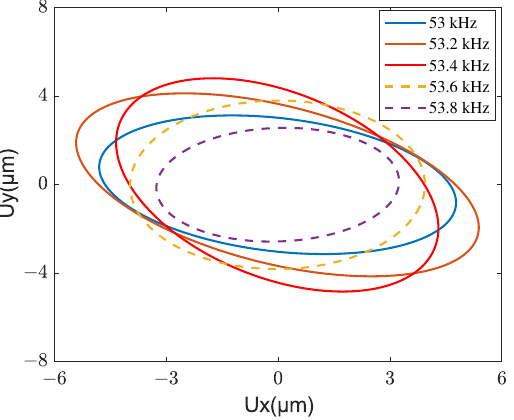
Figure 31. Driving trajectory of the contact tip for different voltage frequencies. The phase difference between the two excitation electrodes (CH1/CH2) is an important parameter affecting the obliqueness of the elliptical trajectory, so it was chosen as the variable, and the steady-state velocity of the mover is measured and simulated, as shown in Figure 32. The amplitude and frequency of excitation voltage are fixed as 100 V and 53 kHz, respectively. The relationship between the velocity and phase closely resembles a sine wave shape. It can be found that the velocity of the mover reverses when the phase difference exceeded 180 ◦ due to the reverse driving of the contact tip. The maximum velocities in the forward and backward directions were observed around 45 ◦ and 315 ◦ . It is noted that three voltage phase deadzone (from 0 ◦ to 5 ◦ , from 175 ◦ to 185 ◦ , and from 355 ◦ to 360 ◦ ) are recognized. Figure 33 shows several driving trajectories with different excitation phase differences. The solid and dashed lines denote clockwise and counterclockwise driving. When the phase difference is around 0 ◦ , the contact tip almost only generates normal displacement and the tangential displacement is too small to drive the mover.